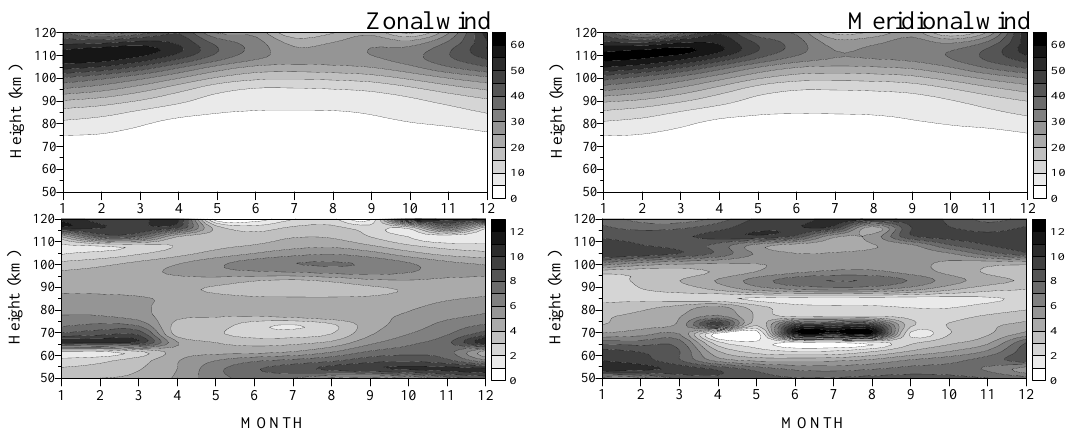
Figure 6 Fig. 6. Altitude-time cross sections of the GSWM-02 semidiurnal tidal characteristics in zonal (left column of plots) and meridional (right